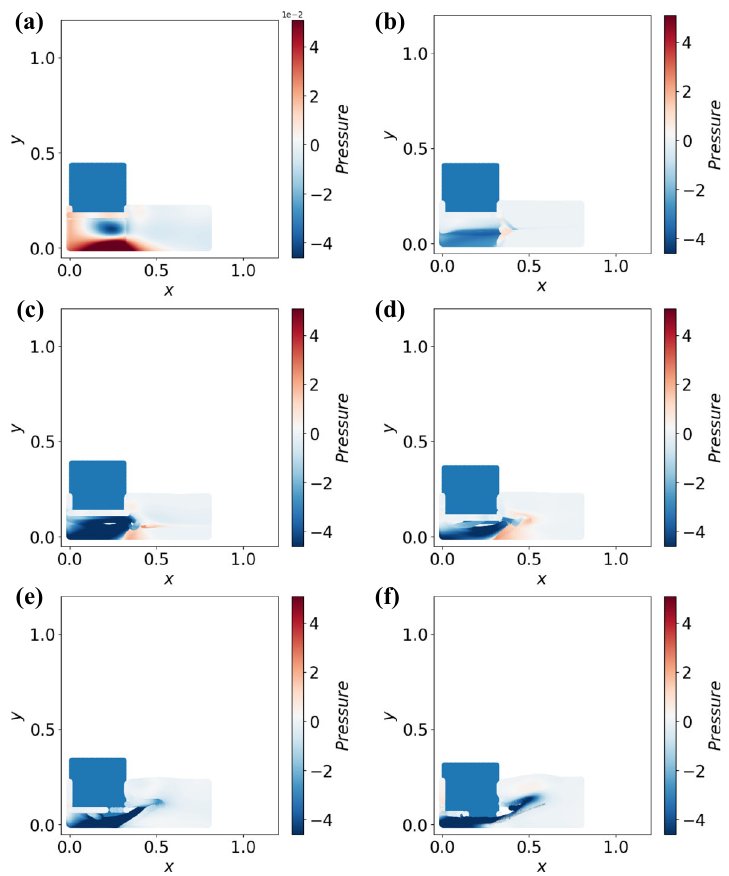
Fig. 9 The surge morphology and pressure distribution diagram. Water depth D = 0 . 21 m and particle density n = 100 / m. Each map corresponds to a different moment. a 2 dt. b 3 dt. c 4 dt. d 5 dt. e 6 dt. f 7